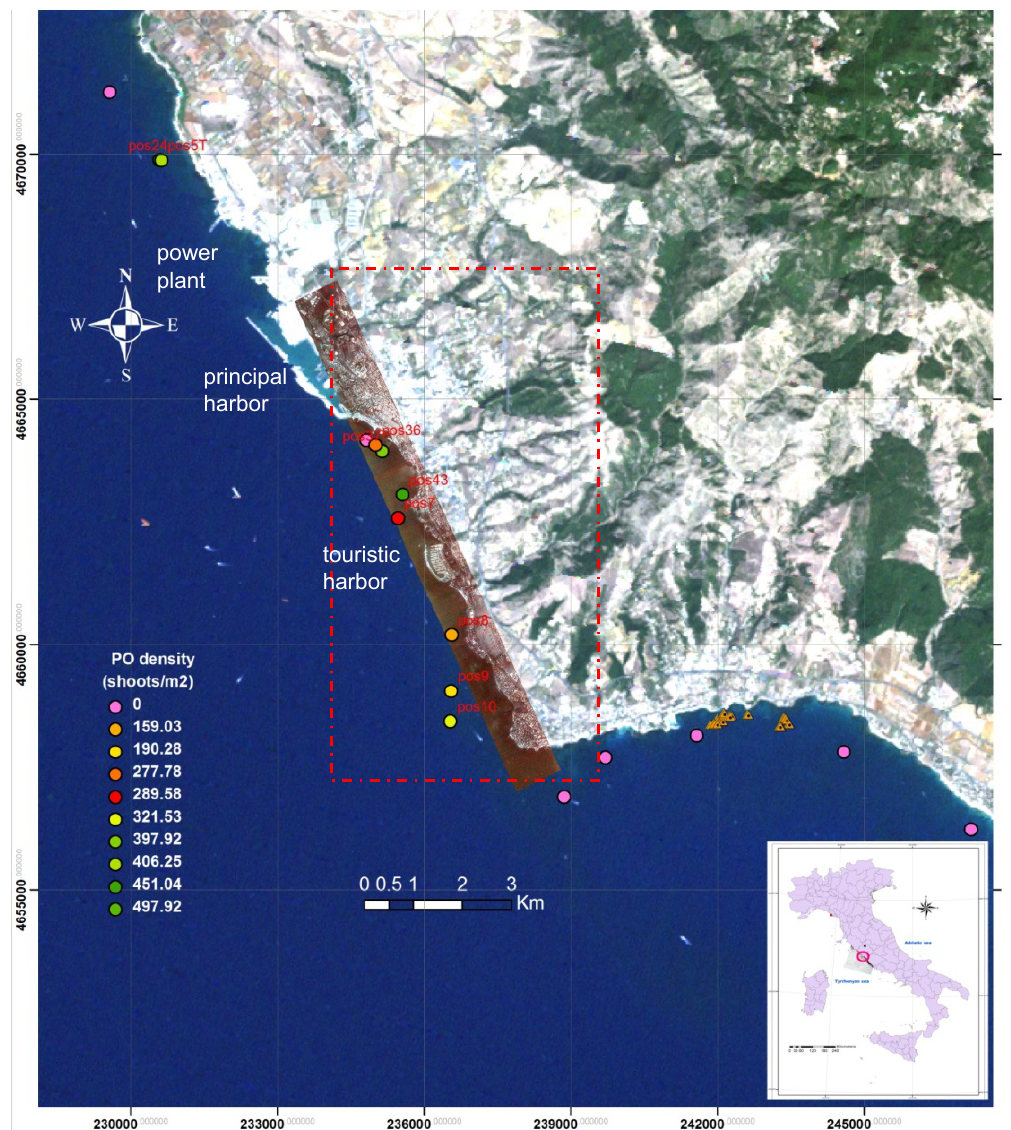
Figure 2. Landsat ETM+ true color synoptic image of the coastal Tyrrhenian area of interest. The georeferenced strip of Daedalus ATM 1268E is superimposed both with PO sampling stations as circular symbols. The violet ones (reported with 0 density in legend) refer to the sampling stations which have been only localized and whose measurements are ongoing. The synoptic image in lower right corner depicts the area of interest as unfilled red circle in the middle Italy, in overlay to MERIS false color k image subset. The yellow d triangles symbols are located in correspondence of the near S. Marinella areas of